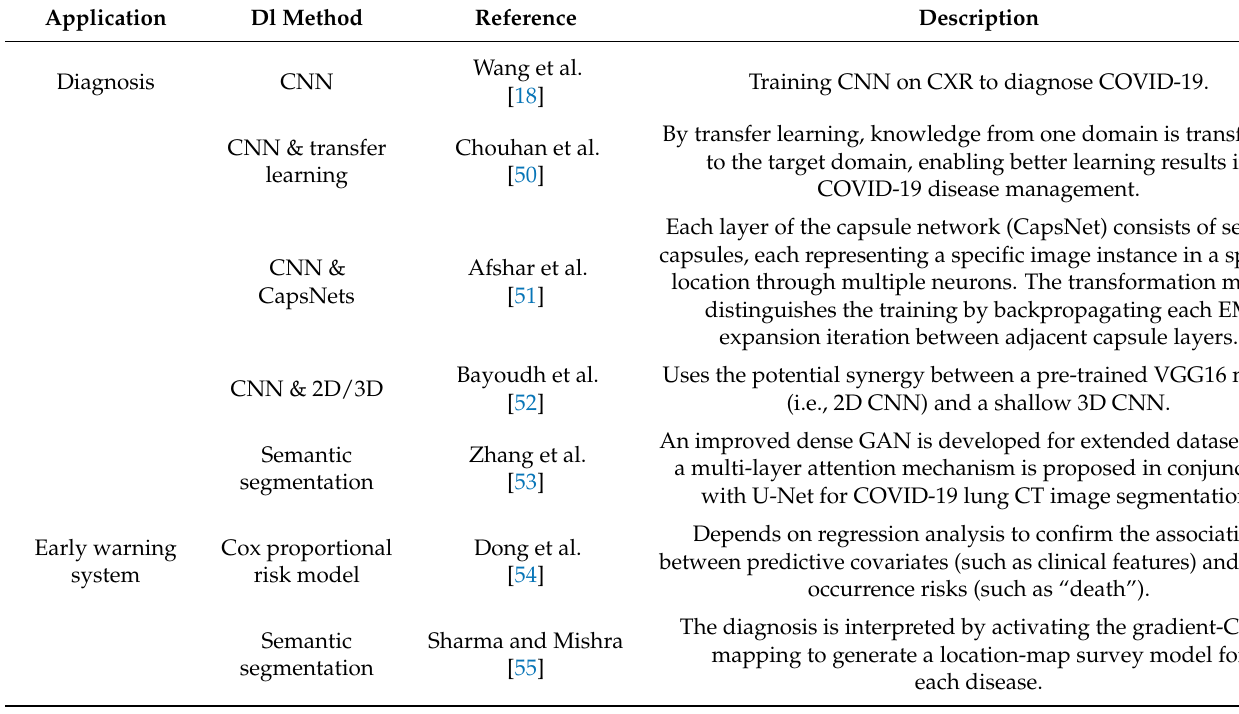
Table 1. Summary of deep-learning methods, their relevant applications and brief technical descrip- tions of each DL